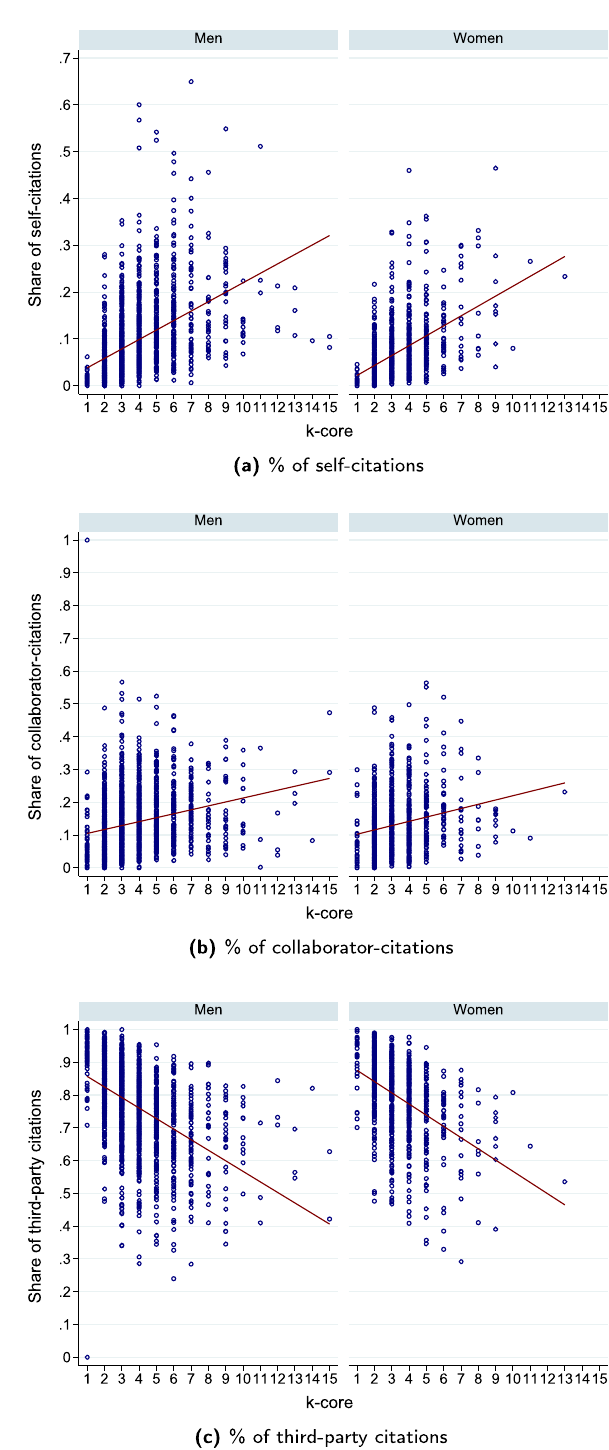
Fig. 3 Relation between k ‑max and type of